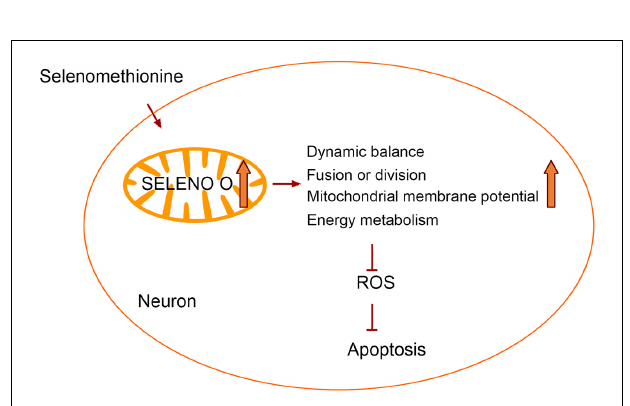
FIGURE 9 | Selenomethionine improves mitochondrial function by upregulating mitochondrial selenoprotein in a model of Alzheimer’s